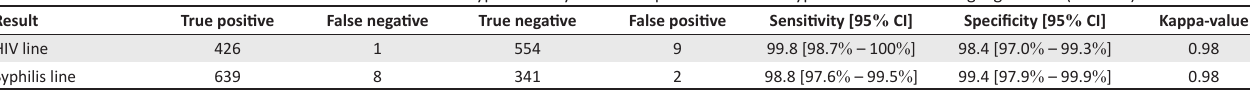
TABLE 2: Performance characteristics of the Chembio DPP HIV-Syphilis Assay when compared to HIV and syphilis reference testing algorithms ( N = 990).